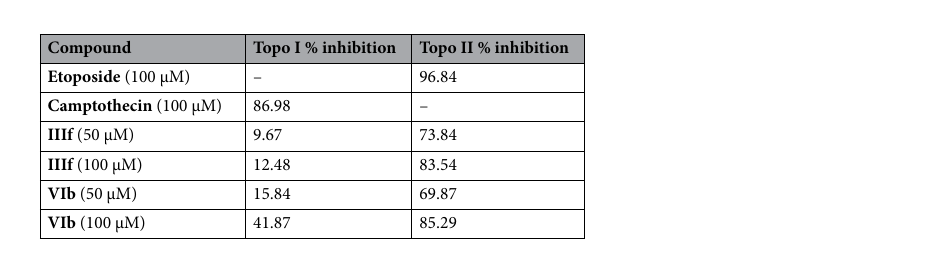
Table 5. Recombinant Topo I and II inhibitory activities (% inhibition) of ( IIIf ) and ( VIb ).